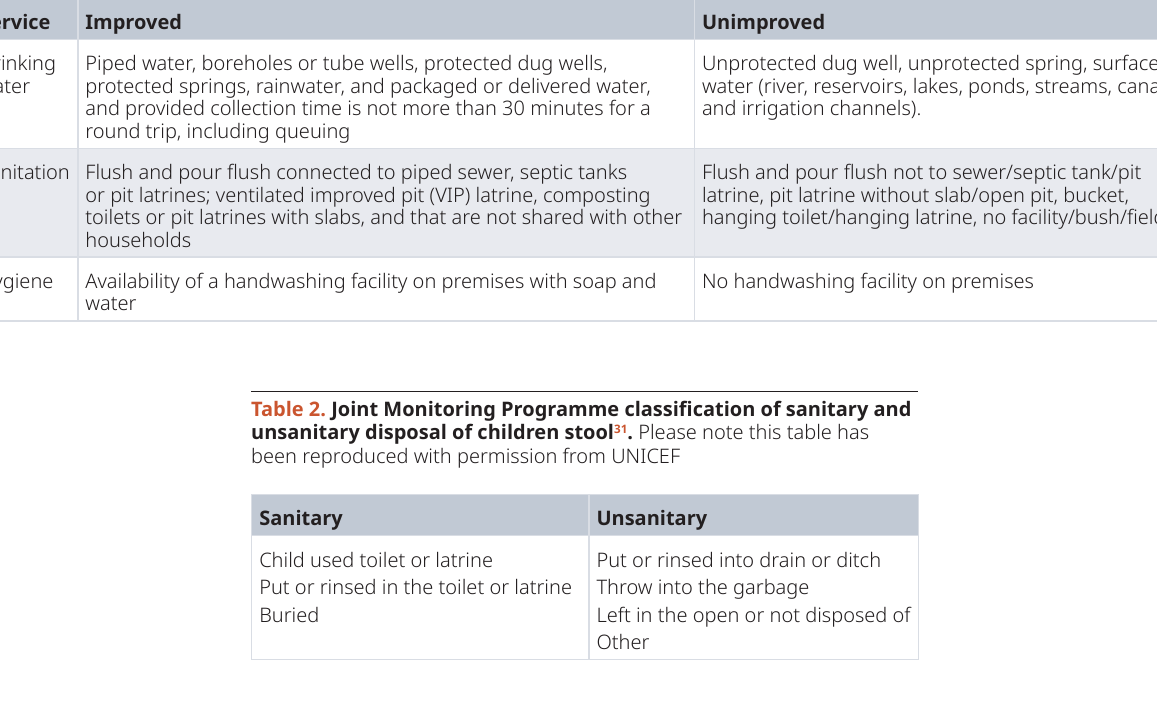
Table 1. Joint Monitoring Programme classification of improved and unimproved water, sanitation and hygiene (WASH) 30 . Please note this table has been reproduced with permission from UNICEF Service